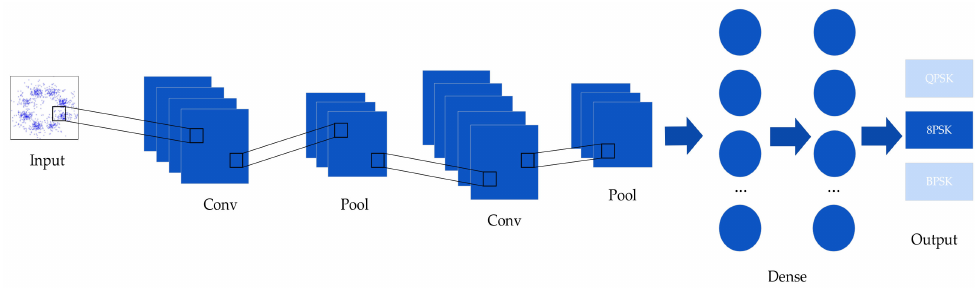
Figure 6. Convolutional neural network